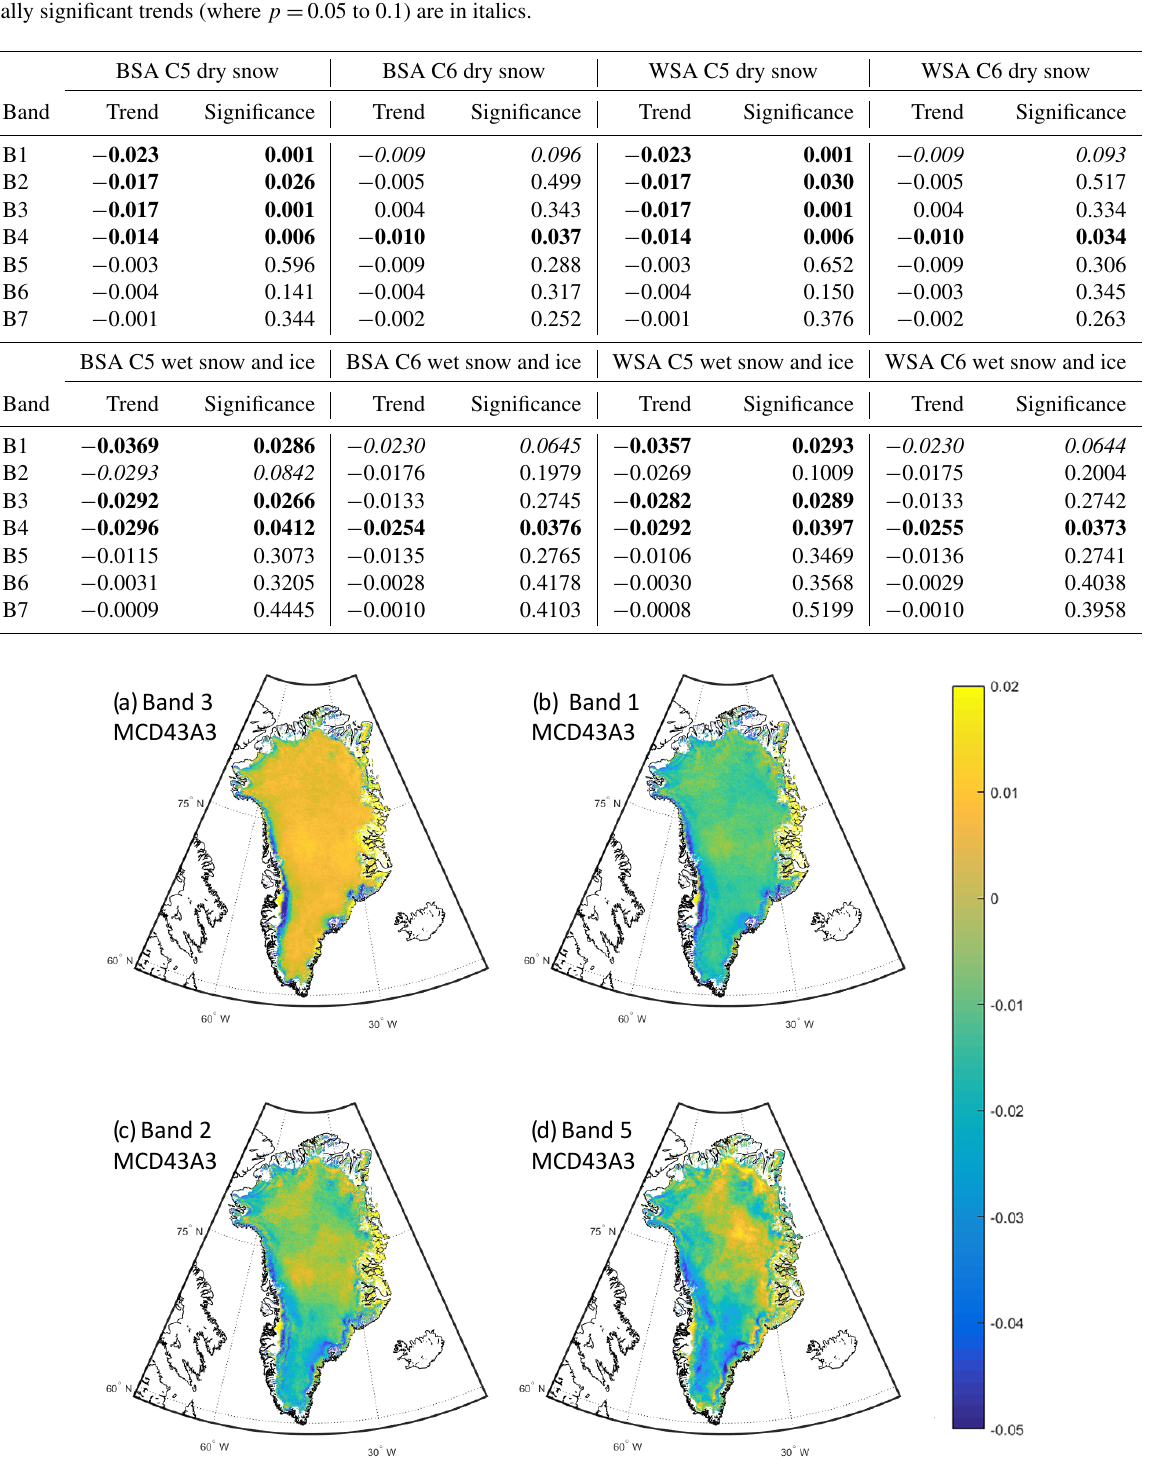
Figure 6. MCD43A3 C6 band 3 (459–479nm), band 1 (620–670nm), band 2 (841–876nm) and band 5 (1230–1250nm) 2003–2016 albedo trends. Band-specific maps show considerable spatial complexity in albedo